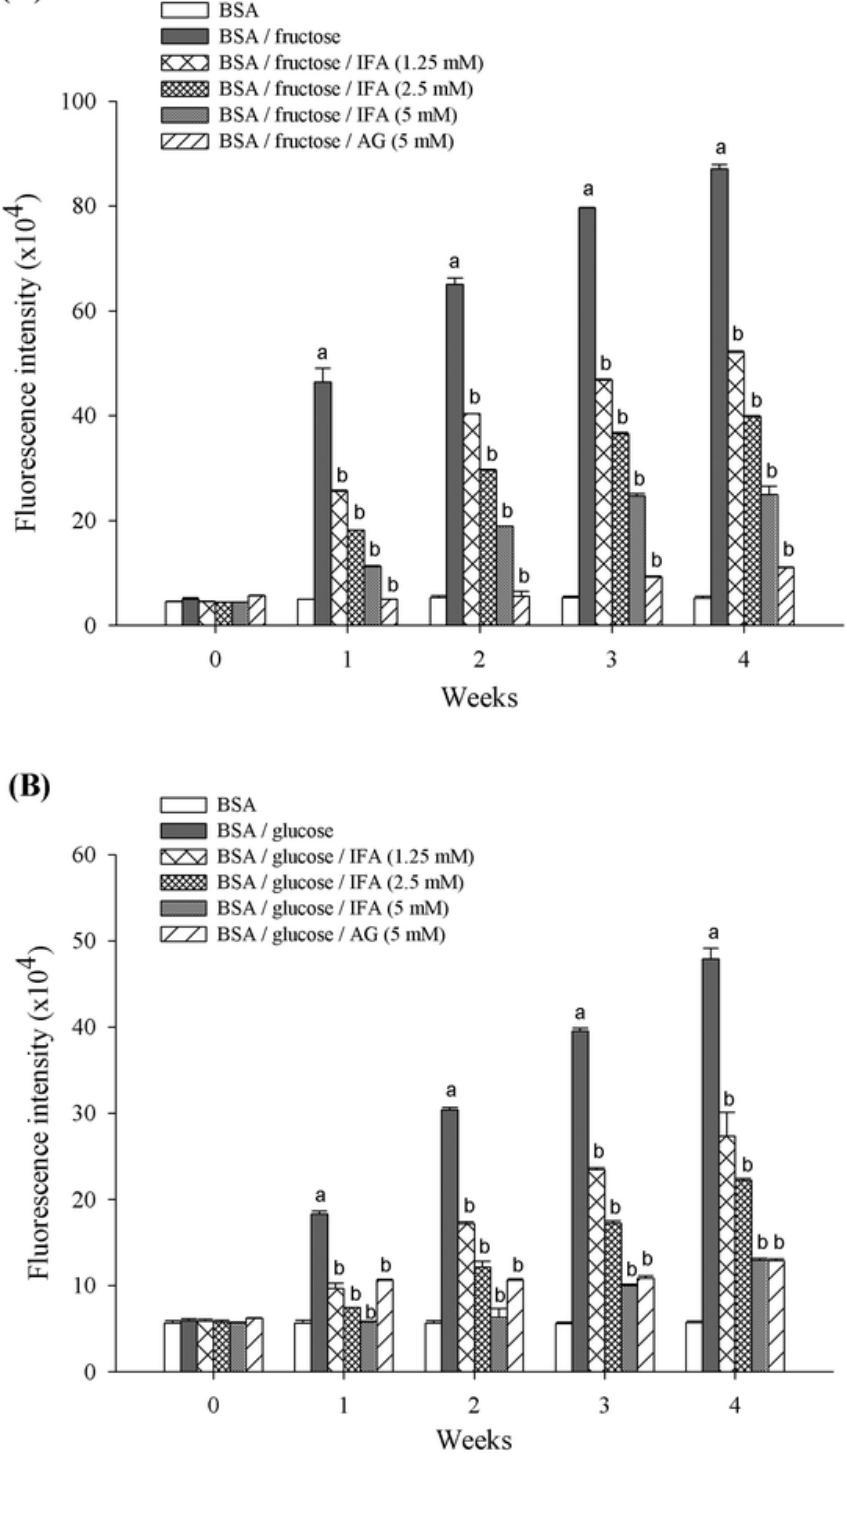
Figure 2. The inhibitory effect of IFA on the formation of fluorescent AGEs in BSA/fructose ( A ) and BSA/glucose ( B ) systems. Results are expressed as mean ± SEM (n = 3). a p < 0.05 when compared to BSA, b p < 0.05 when compared to BSA/fructose or